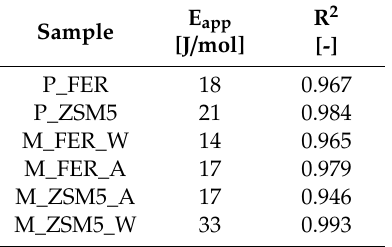
Table 4. Apparent activation energy for methanol conversion. R 2 is the correlation factor.